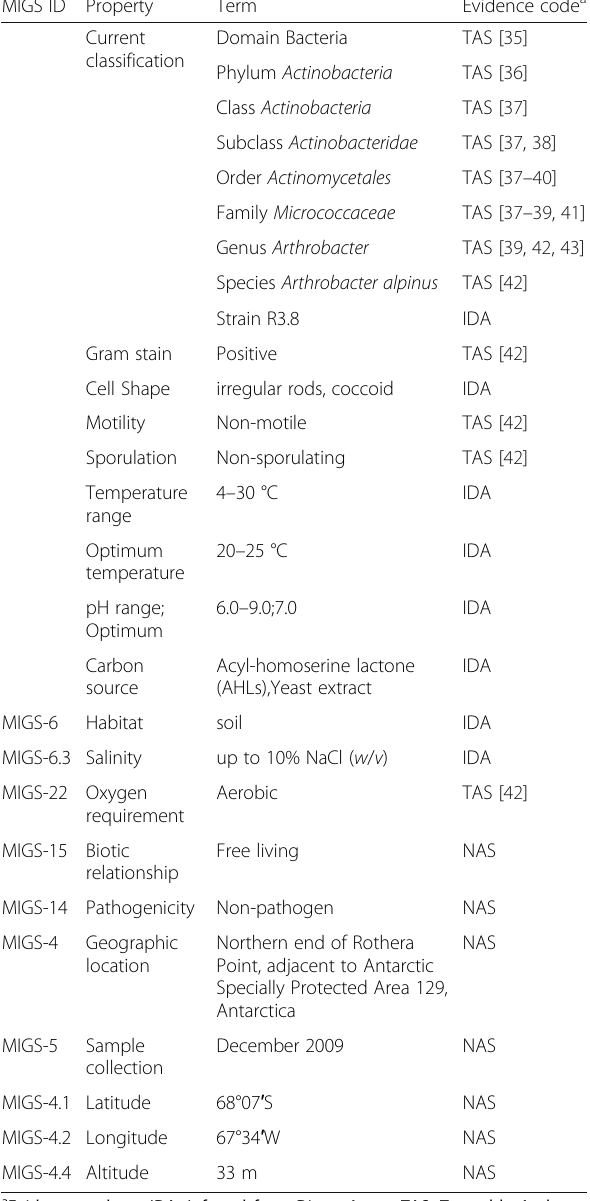
Table 1 Classification and general features of Arthrobacter alpinus R3.8 according to the MIGS recommendations